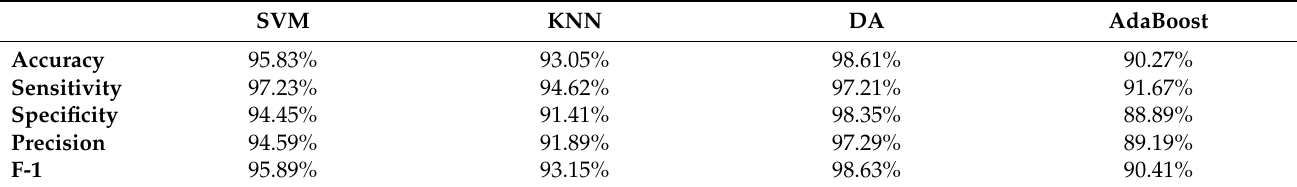
Table 8. Classification performance of the employed classifiers, REST vs.